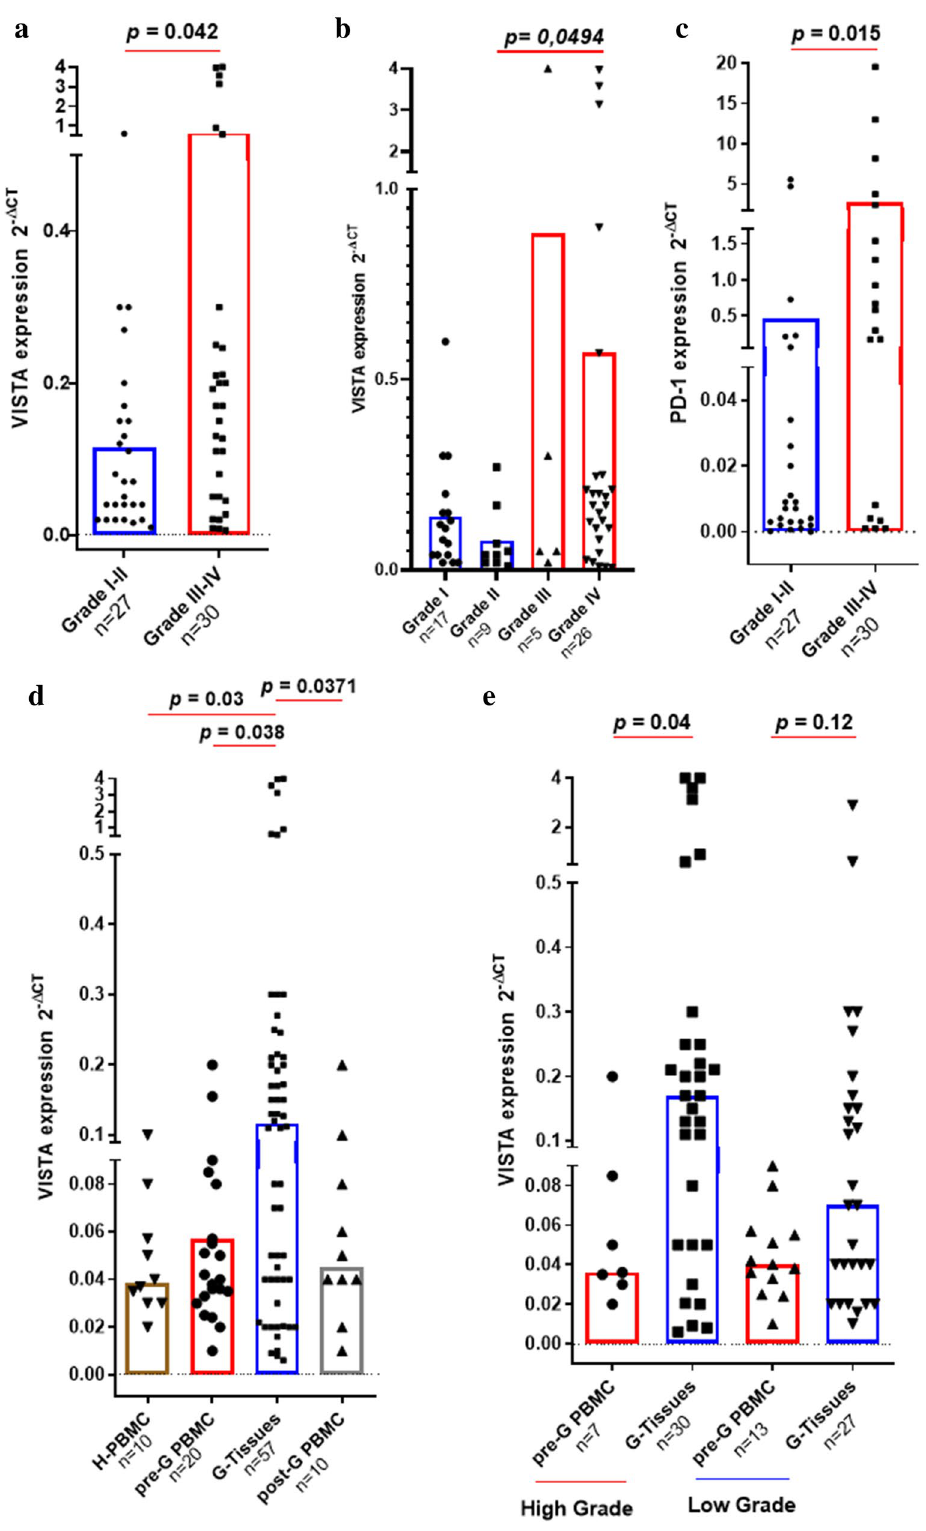
Figure 1. VISTA gene expression was upregulated in glioma tissues relative to PBMC of healthy donors (Moroccan cohort). VISTA and PD-1 transcripts expression were performed using RT-PCR analysis. ( a ) VISTA gene strongly expressed in grade III–IV compared with grade I–II of glioma patients. ( b ) VISTA mRNA expressionwas significantly increased in advanced glioma (grade IV) compared to grade II. ( c ) PD-1 was highly expressed in advanced glioma grading (grade III–IV). ( d ) Elevated expression of VISTA gene in glioma tissues (G-Tissues) compared to PBMC of healthy donors (H-PBMC) and PBMC of glioma patients before (pre-G PBMC) and after surgery (post-G PBMC). (e) VISTA was upregulated in high grade glioma tissues (grade III–IV) relative to PBMC of the same patients. Paired t-test was used to make a statistical comparison of VISTA and PD-1 expression between groups. p value less than 0.05 was considered as statistically significant for all statistical